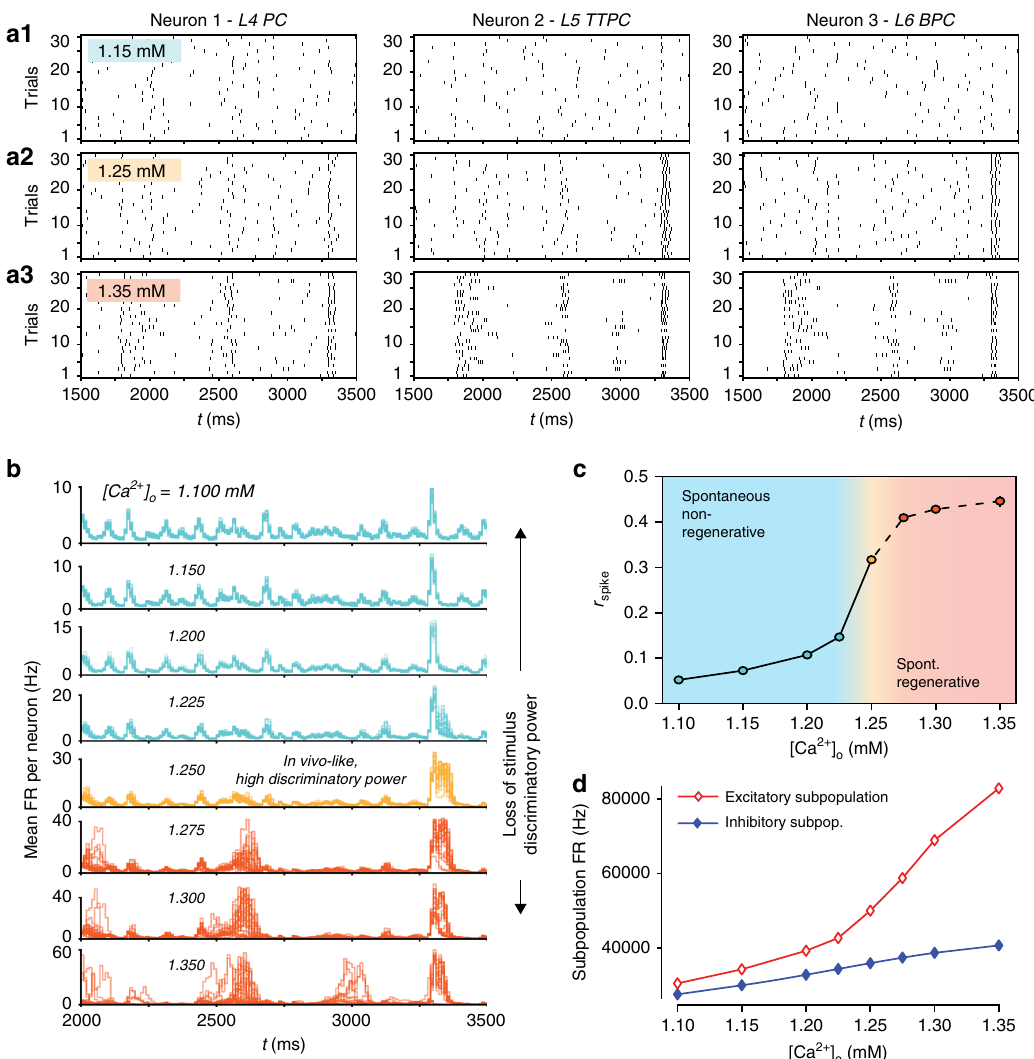
Fig. 8 High reliability emerges near a critical EI-balance. a1 – 3 Raster plot of spike times of the same three example neurons as in Fig. 6d, during 30 independent trials of evoked activity, for three different extracellular calcium concentrations ([Ca 2 + ] o = 1.15, 1.25, 1.35 mM). b Population fi ring rates for all 30 trials for eight different extracellular calcium concentrations. Loss of stimulus discriminatory power away from [Ca 2 + ] o = 1.25mM as observed by Markram et al. 17 . c Mean reliability of 2024 pyramidal neurons from layers 4, 5, and 6 during the evoked response vs. extracellular calcium concentration (mean of 30 trials ± 95% con fi dence interval). d Total population fi ring rates for excitatory and inhibitory subpopulations in the whole microcircuit